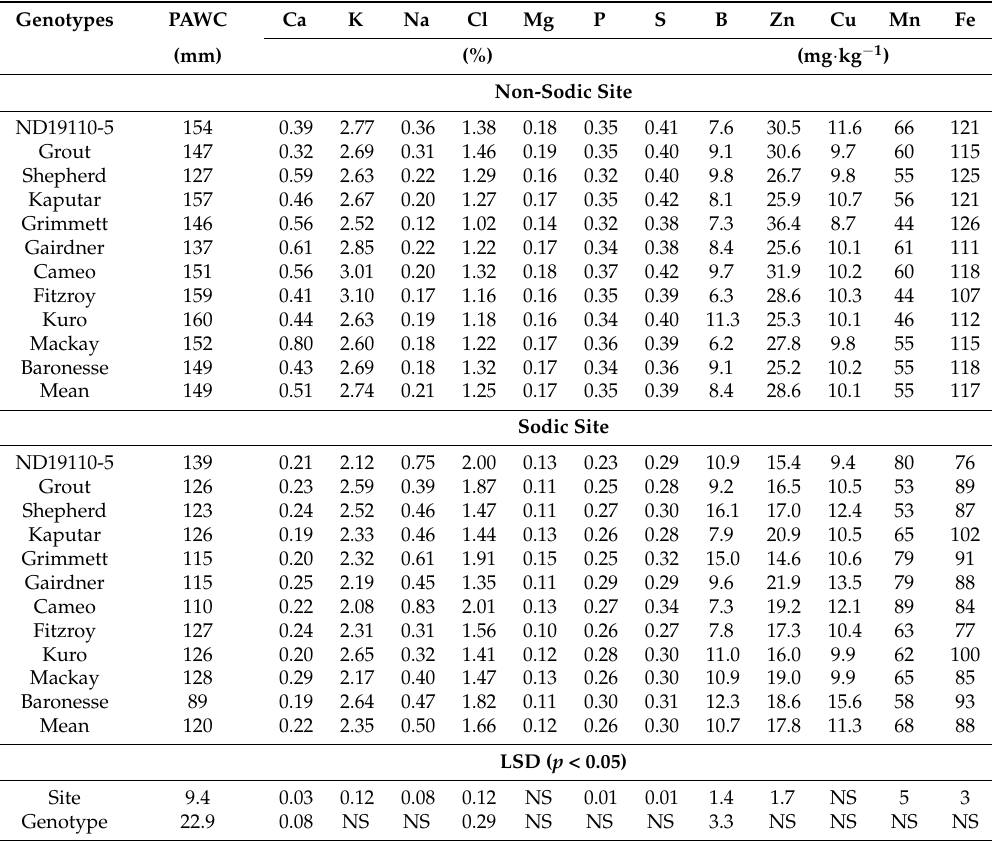
Table 3. Plant available water capacity (PAWC) and nutrient concentrations in barley genotypes grown at a non-sodic site and sodic site in 2008.